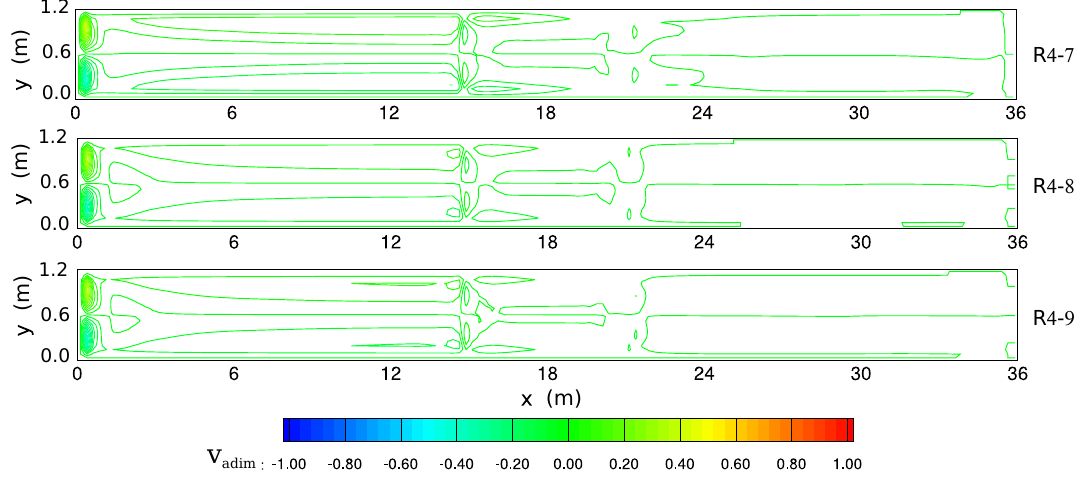
Figure 7. V velocity component at 0 . 176 m, 0 . 208 m and 0 . 215 m from the bottom, for the cases R4-7, R4-8 and R4-9, respectively. Where v